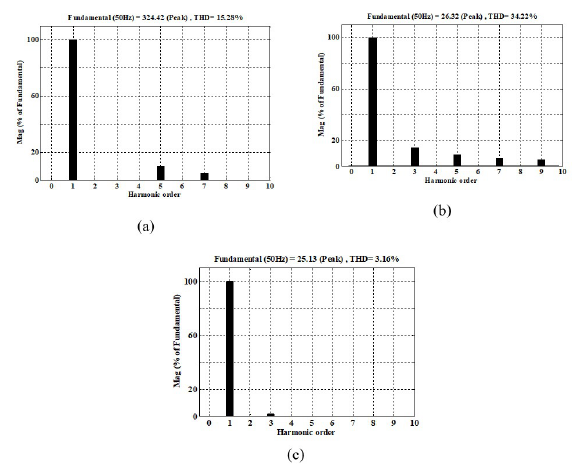
Fig. 6. Performance analysis under distorted Grid supply conditions.